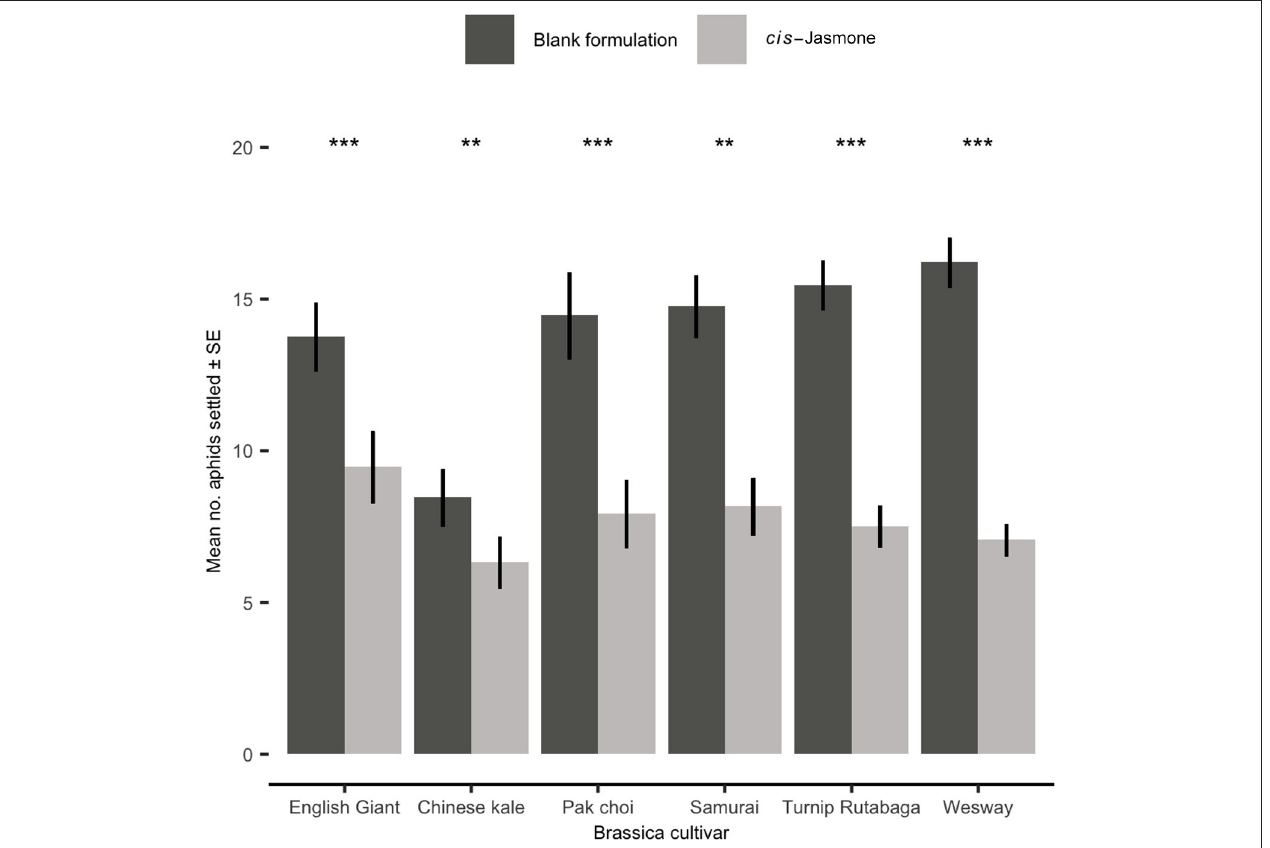
FIGURE 3 | Settlement of Myzus persicae (Mean ± SE) after 24h on blank formulation (control) and cis- jasmone treated plants in a series of choice test bioassays (50 aphids released in each replicate; n = 10). Asterisks denote differing levels of statistical significance: ** < 0.01 and *** < 0.001 (generalised linear models with either Poisson or quasi-Poisson probability